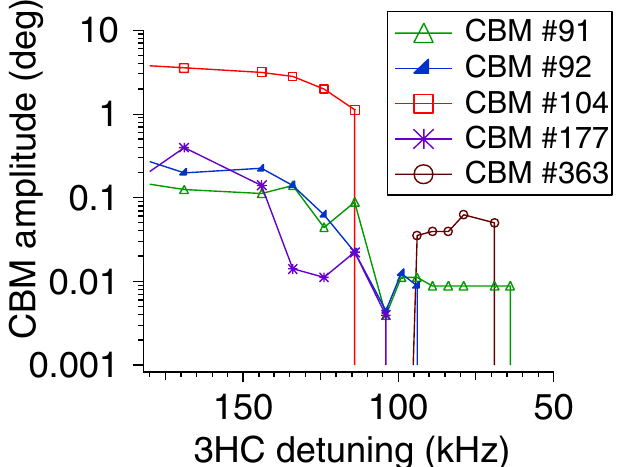
FIG. 3. (Color) CBMs amplitude versus 3HC tuning for a 90% (cid:1) 315 mA , E (cid:1) 2 : 0 GeV filling of the ring; I beam